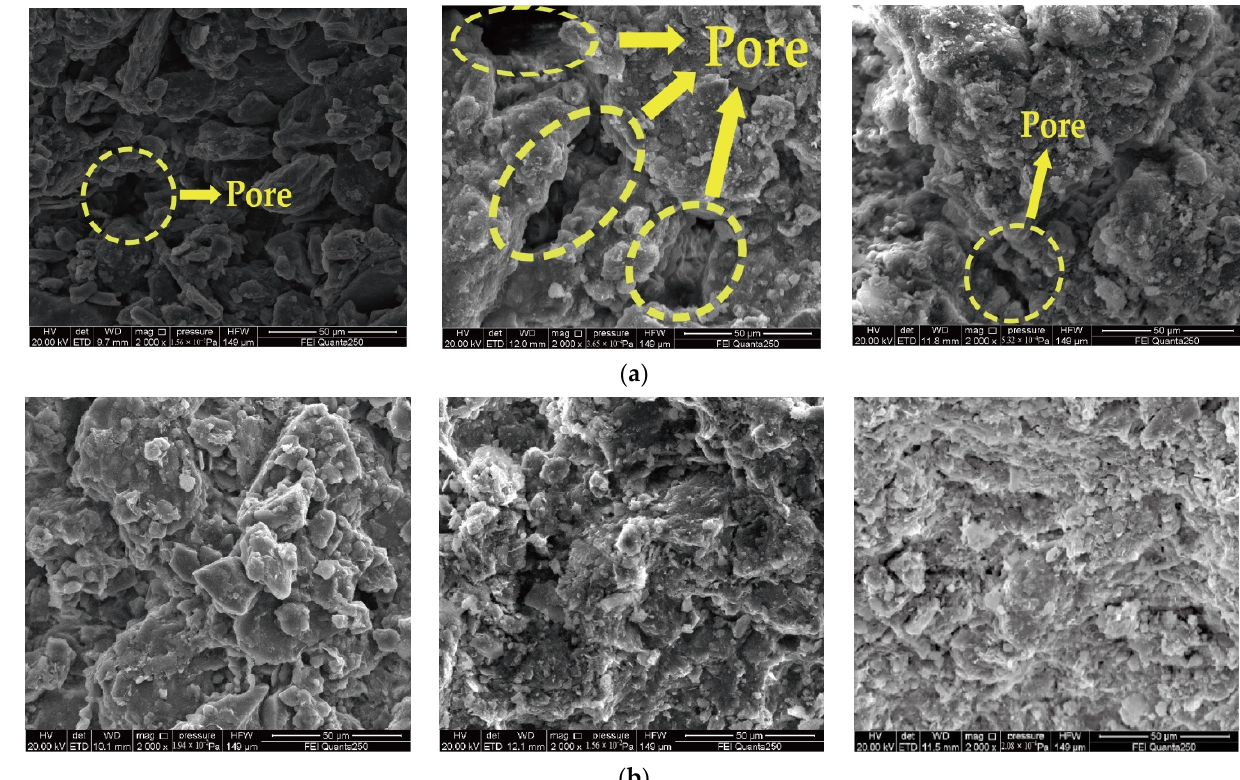
Figure 5. Electron microscope images of wall soil samples and trench soil samples. ( a ) Wall soil samples; ( b ) trench soil samples.